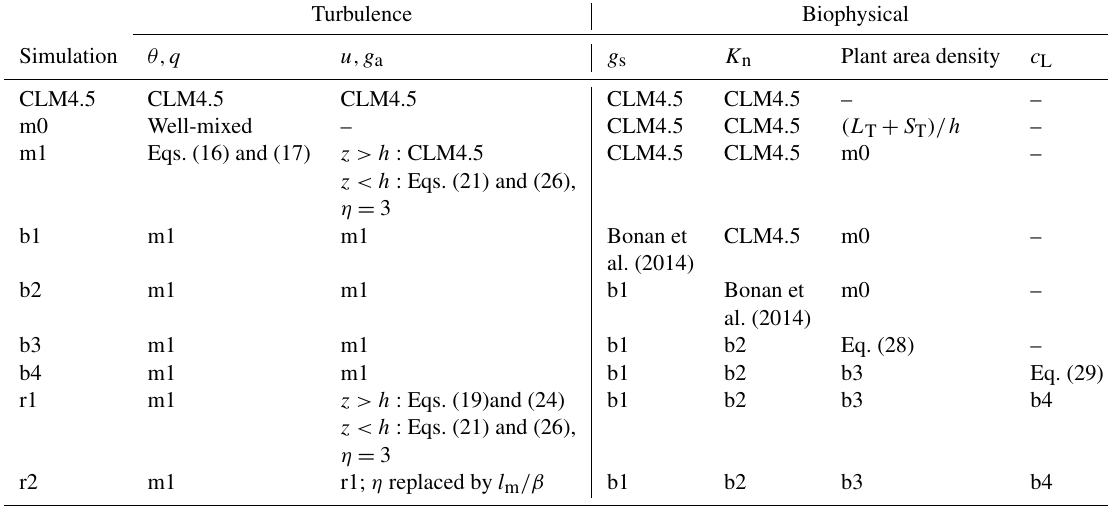
Table 4. Summary of simulation changes to the turbulence parameterization and leaf